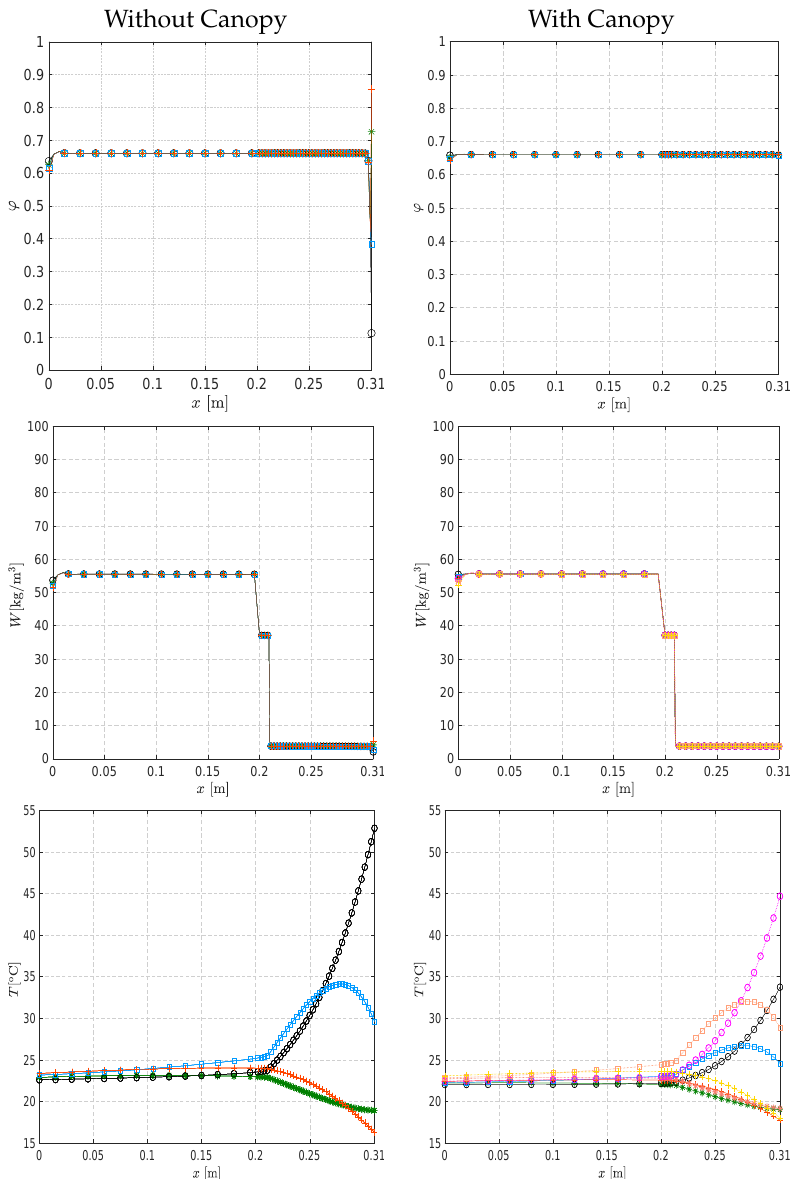
Figure 14. Evolution of the relative humidity, water content and temperature throughout the cross section of the constructive solution with ICB 0.10m thick: ( ∗ ) t = 216 h; ( ◦ ) t = 222 h; ( (cid:3) ) t = 228 h; (+) t = 234 h. Shortwave radiation extinction coefficients of k s = 0.9 (solid line) and k s = 0.6 (dotted line) were used in the solution containing the